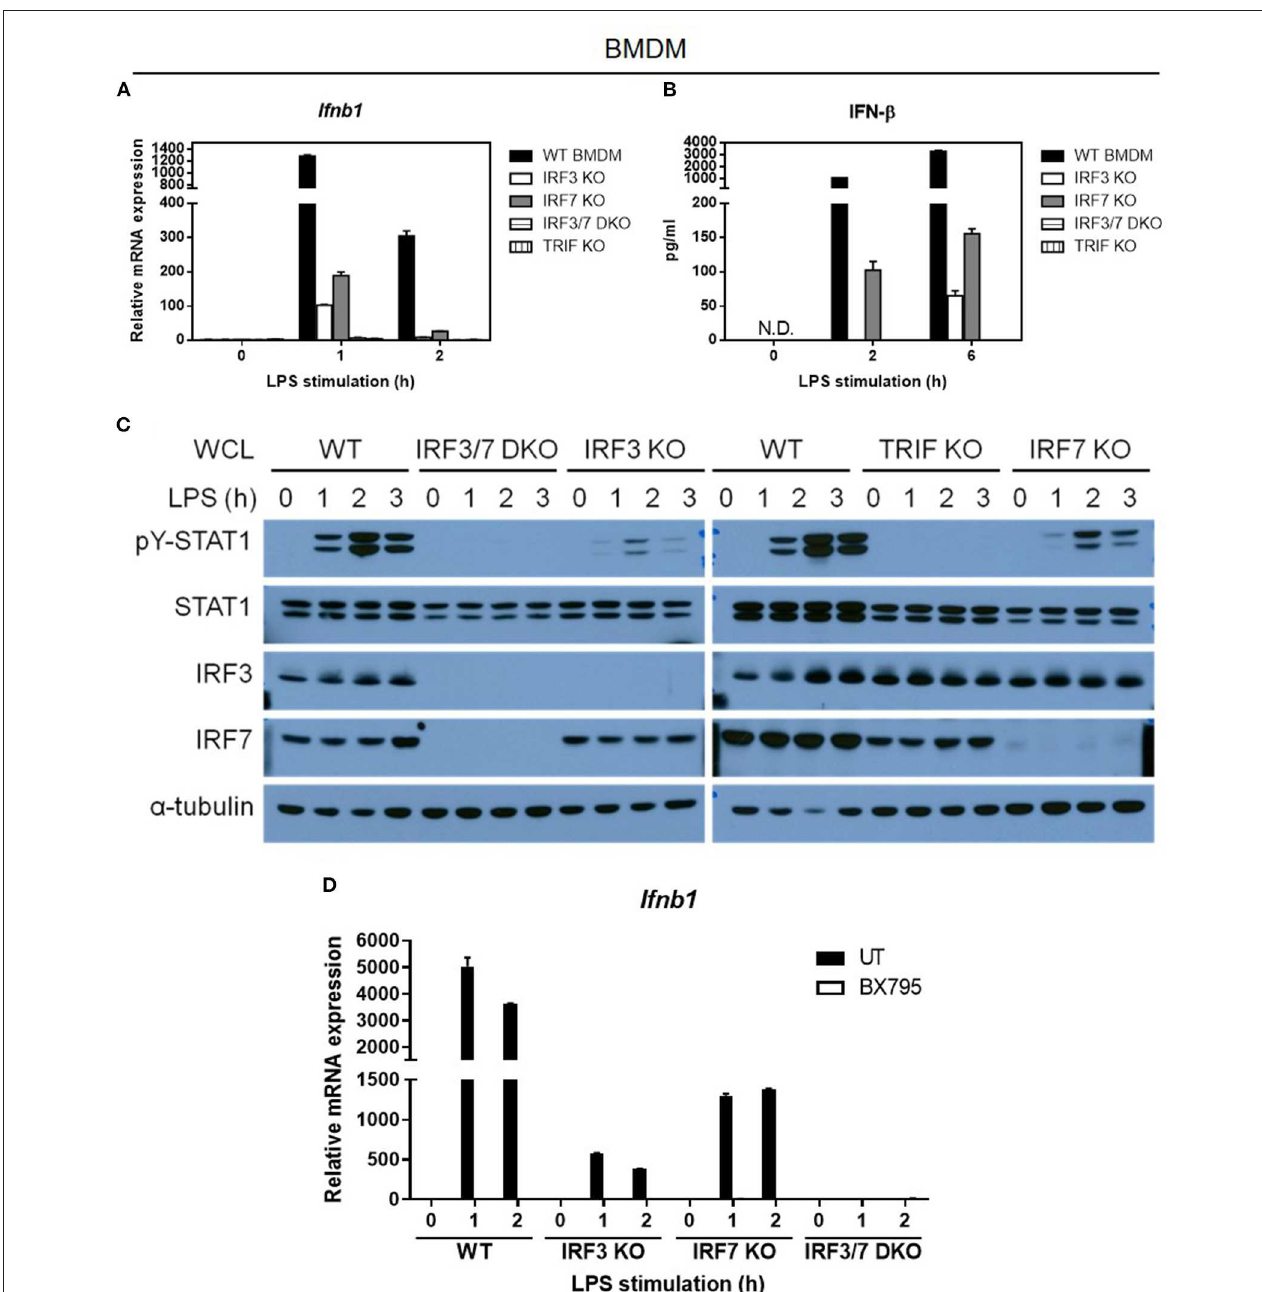
FIGURE 7 | TBK1 is required for the activation of both IRF-7 and IRF-3 downstream of TRIF for optimal IFN- β expression in LPS-challenged macrophages. (A,B) Real-time PCR and ELISA analysis of IFN- β gene and protein expression of BMDMs from IRF-3, IRF-7, and TRIF single knockout mice, and IRF-3-IRF-7 double knockout mice, compared to wild-type control littermates, stimulated or not with 100ng/ml LPS for the indicated times. Ifnb1 expression was normalized to Gapdh and expressed relative to the levels observed in un-stimulated wild-type control cells. Data are presented as mean ± SD of duplicate determinations from one representative of at least two independent experiments (N.D.: not detected). (C) Western immunoblot analysis of phospho-STAT1 and total STAT1 protein expression in whole cell lysates of BMDMs from IRF-3, IRF-7, and TRIF single knockout mice, and IRF-3-IRF-7 double knockout mice, compared to wild-type control littermates, stimulated or not with 100ng/ml LPS for 0–6h. Data are representative of at least two independent experiments. (D) Real-time PCR analysis of IFN- β gene expression in BMDMs from IRF-3 single knockout mice, IRF-7 single knockout mice, and IRF-3-IRF-7 double knockout mice, compared to wild-type control littermates, pre-treated or not with 2 µ M BX795 (TBK1 inhibitor) for 1h, and then stimulated or not with 100ng/ml LPS for 0–2h. Ifnb1 expression was normalized to Gapdh and expressed relative to the levels observed in un-treated and un-stimulated wild-type control cells. Data are presented as mean ± SD of duplicate determinations from one representative of at least two independent